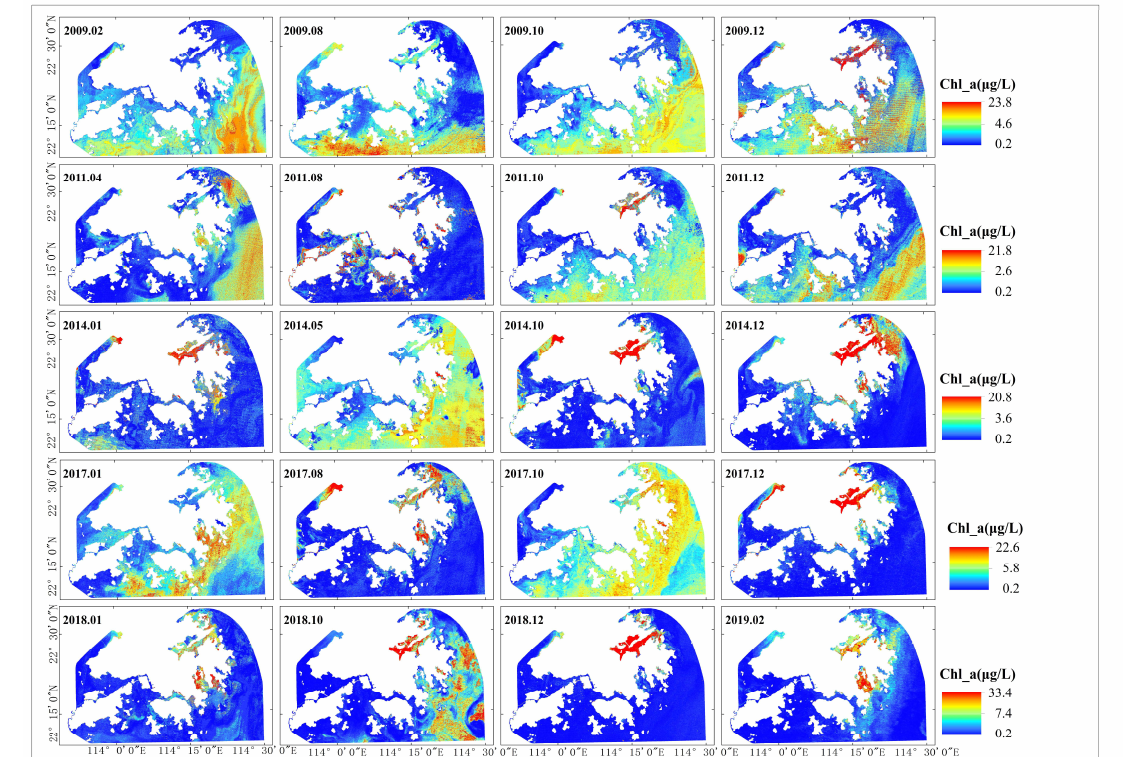
Figure 5 Temporal and spatial variation of chlorophyll a concentration in Hong Kong oceans form2009 to